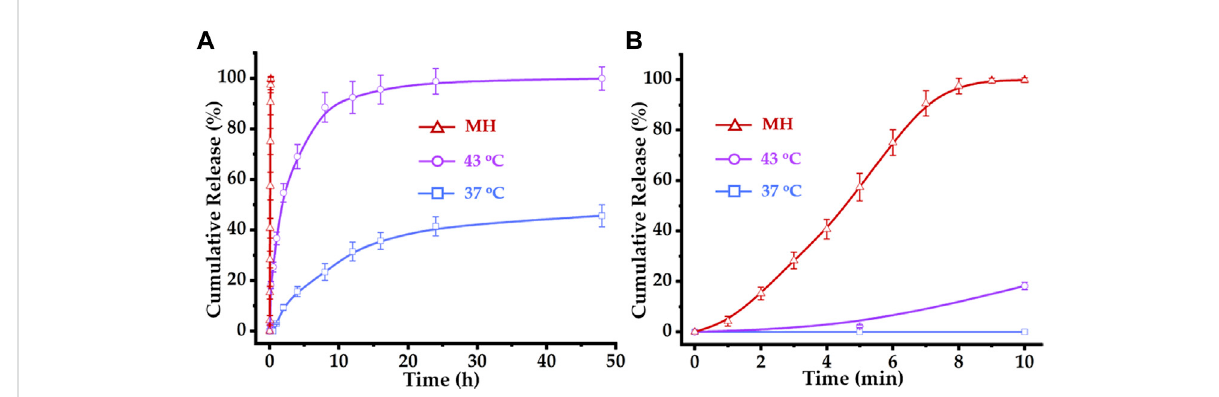
FIGURE 6 Drug release pro fi les of DOX – MTM at 37 ° C, 43 ° C and AMF ( f = 114 kHz and H applied = 63.6 kA/m): (A) long-term (48 h) and (B) short-term (10 min) drug release pro fi les of DOX – MTMs under corresponding